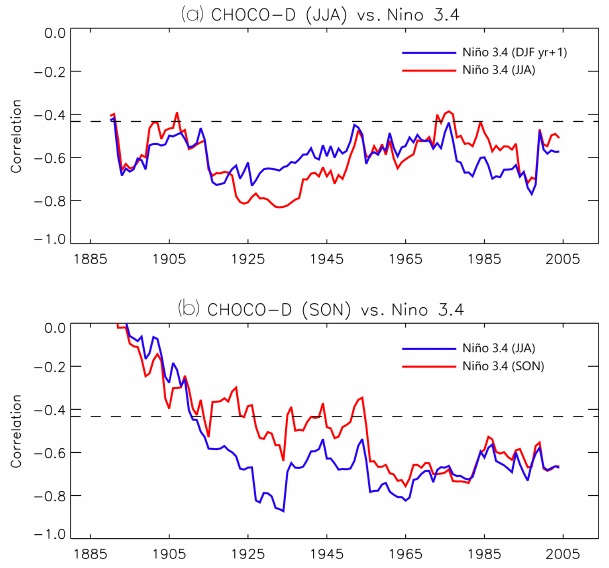
Figure 11. (a) Twenty-one-year running Pearson’s correlation coefficient between CHOCO-D (JJA) and El Niño3.4 in Phase (JJA, red line) and the following boreal winter (DJF yr + 1, blue line); (b) 21yr running Pearson’s correlation coefficient between CHOCO-D (SON) and El Niño3.4 the previous boreal summer (JJA, blue) and in phase (SON, red line). Dotted line indicates sta- tistically significant correlation at p < 0 .